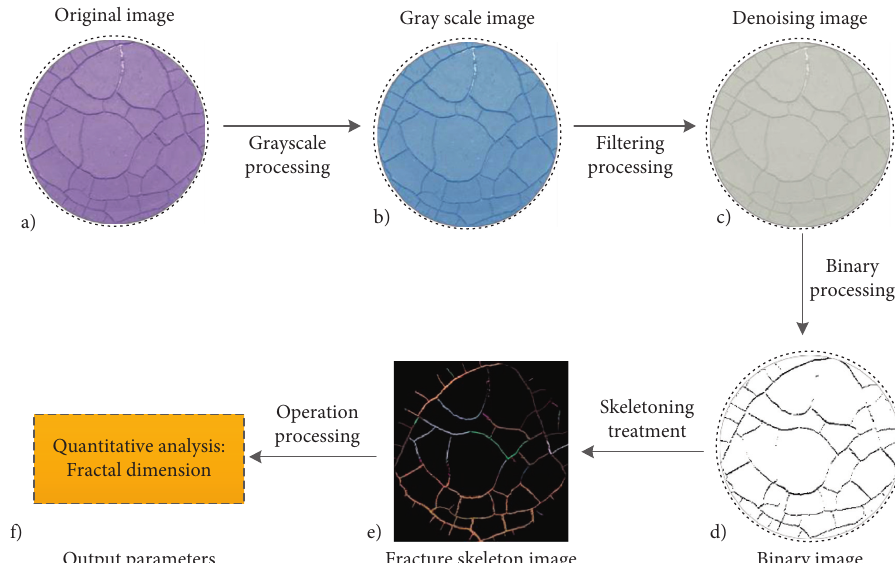
Figure 3: Flowchart of processing crack